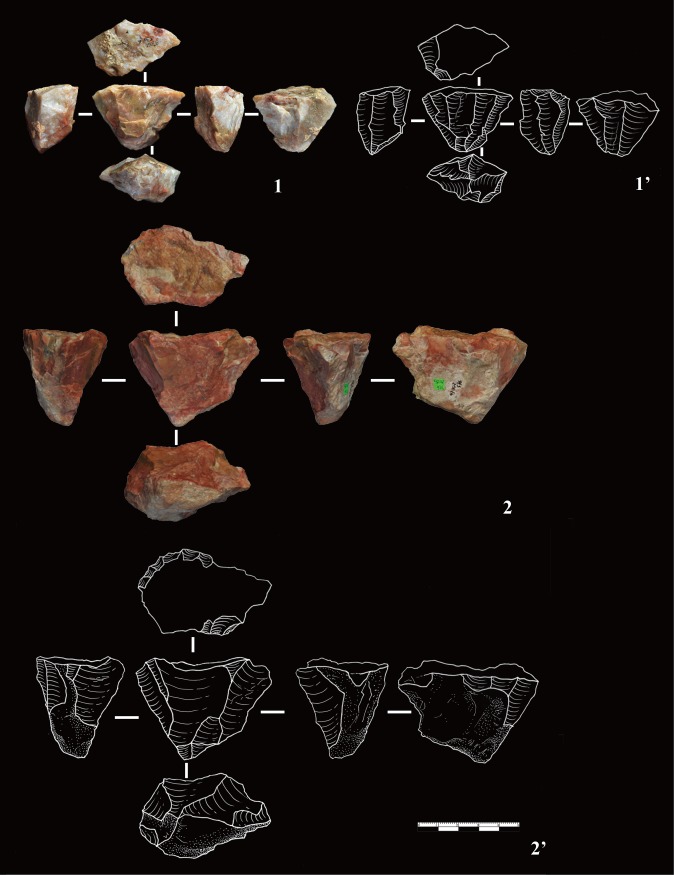
Wedge-shaped cores from DGT.Wedge-shaped cores were previously described and named by Hou [12, 23, 26, 27]. The cores have single platforms which are sometimes prepared, resulting in the striking and production of a series of small, enlongated flakes. No.1 is a heavily exploited core, with negative flakes scars visible on every face. No. 2 is partly exploited, though showing platform preparation and the striking of small flakes from a single platform. The two examples are similar show the reduction direction and the morphology of the “DGT core”.